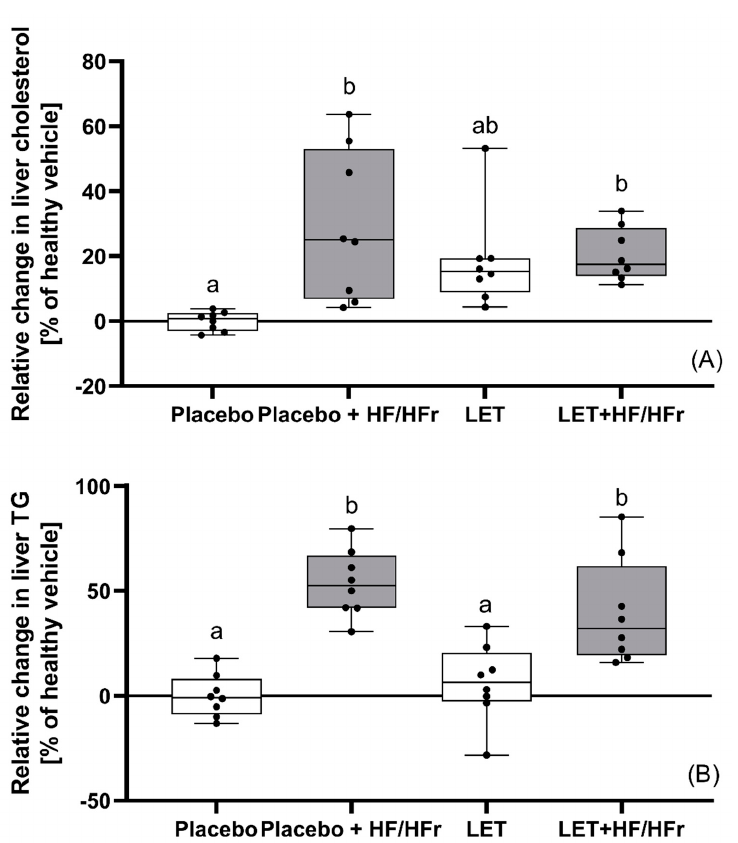
Figure 2. Terminal changes in the liver cholesterol ( A ) and triglycerides ( B ). The data are presented as medians, with boxes and whiskers representing the interquartile range and the 5th − 95th percentiles ( n = 8 per group), analyzed using one − way ANOVA followed by Tukey’s post hoc test. Values with different letters show statistically significant differences ( p < 0.05). Serum testosterone concentration was robustly higher by a factor of 1.6 in the LET+HF/HFr group of mice ( p < 0.05, Figure 3) compared to the control. Moreover, testosterone levels in the placebo mice on the HF/HFr diet were significantly higher ( p < 0.05) than in the LET-treated group. In the LET-treated group, the LET+ HF/HFr group, and the placebo mice on the HF/HFr diet, an increased number of corpus luteum were observed compared to the placebo-treated mice on the standard diet. Moreover, the placebo mice on the HF/HFr diet had the largest number of ovarian follicles of the four groups. This group also had the thickest granulosa layer in the follicle, while in both the LET-treated and the LED+HF/HFr groups, this layer’s thickness was visibly reduced. Furthermore, the LET+HF/HFr group had the greatest follicle diameter and the thickest theca folliculi. Follicular atresia and the presence of cysts were observed not only in both the LET-treated groups but also in the group of placebo-treated mice on the HF/HFr diet. Interestingly, the changes in ovarian morphology in the LET-treated mice were milder than in the LET+HF/HFr group, at least partly due to the smaller number of cysts and lesser degradation of the granular cell layer (Figures 4–9).